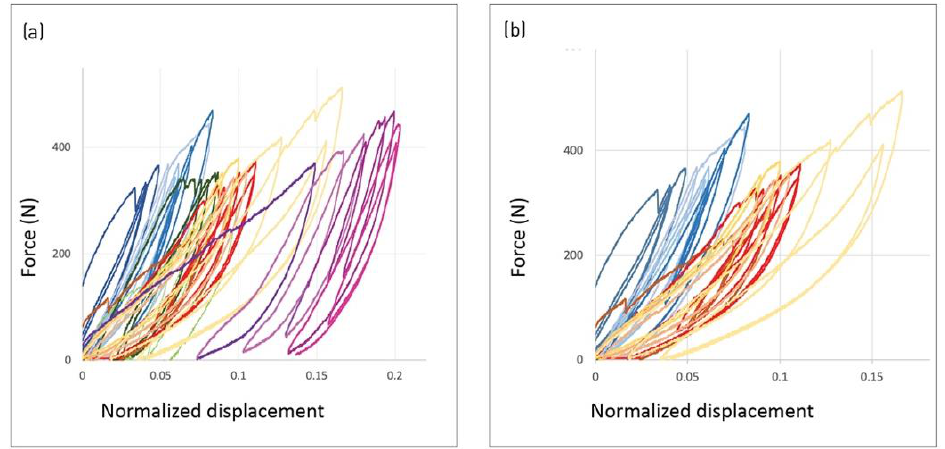
Figure 9. Effect of pleat types force plotted against normalized deformation and grouped by color shades. ( a ) All samples combined: one simple pleat (blue); one full pleat (red/yellow); three simple pleats (green); three full pleats (purple). ( b ) Comparison between simple and full pleat types: simple pleat (blue), showing steeper curves and smaller enclosed area in path; full pleat (red), showing larger enclosed area and shallower curves.